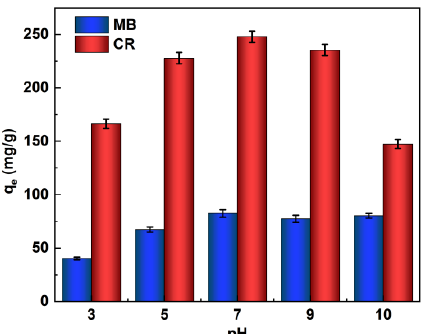
Figure 3. Effects of initial pH on the MB and CR adsorption capacity (adsorption time t = 6 h, ambient temperature T = 20 °C).